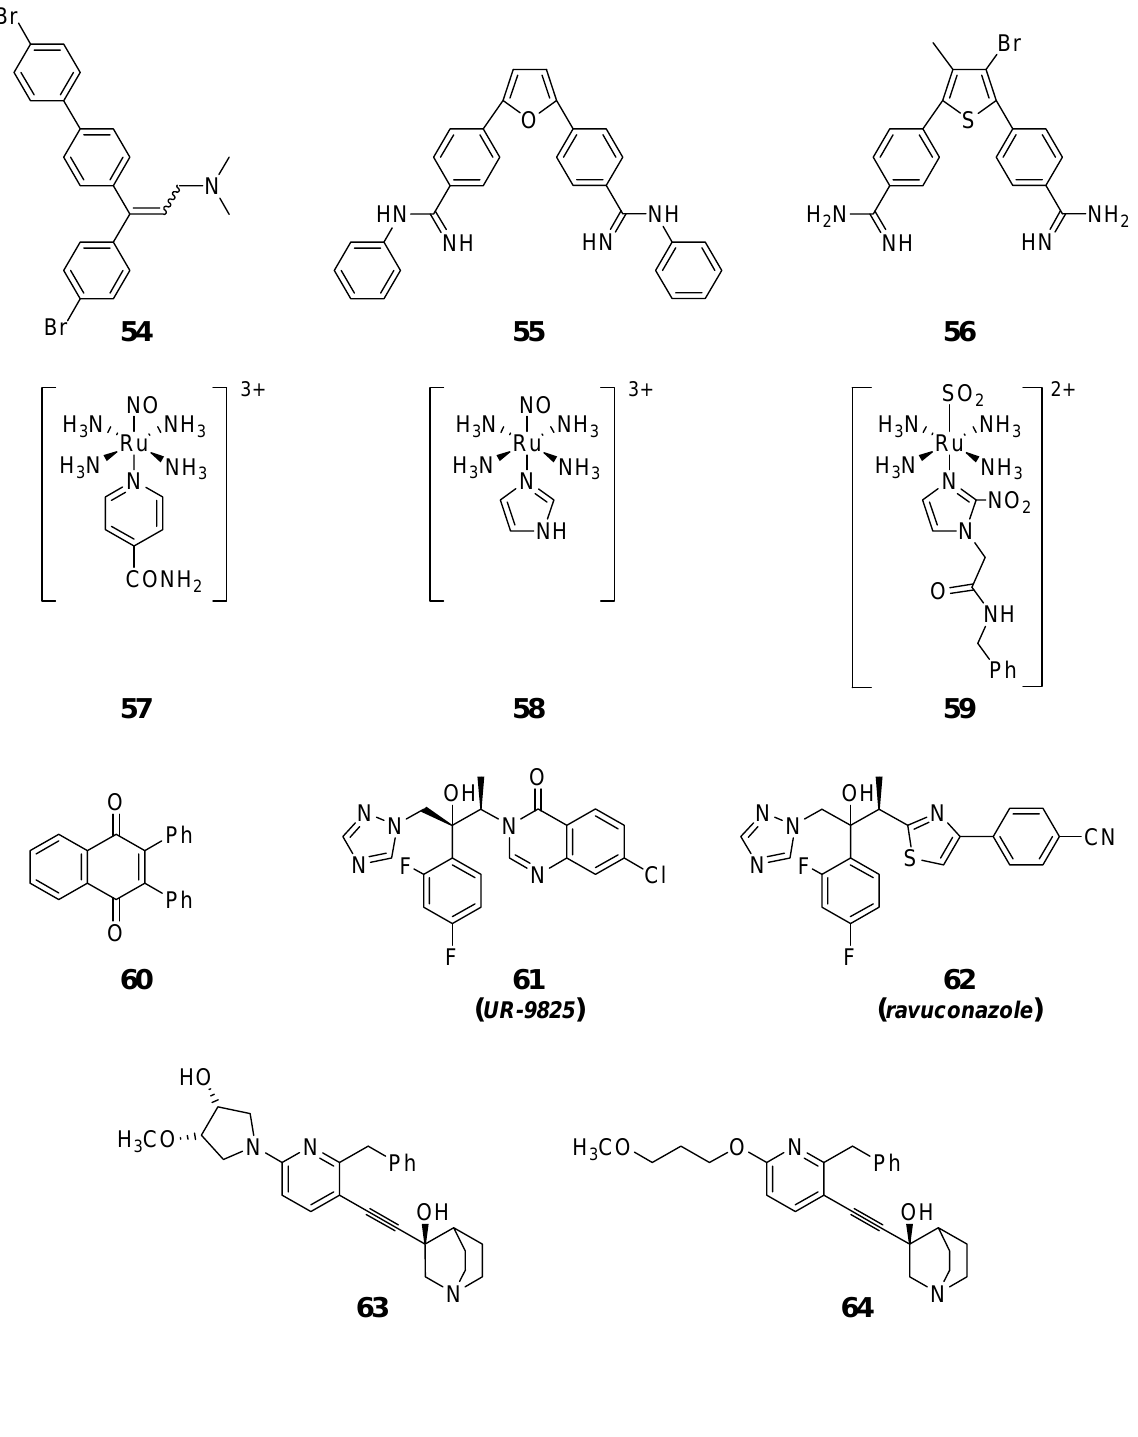
Figure 4. Examples of anti- T. cruzi products emerging from the synthetic medicinal chemistry, hitherto at the “hit-to-lead” development